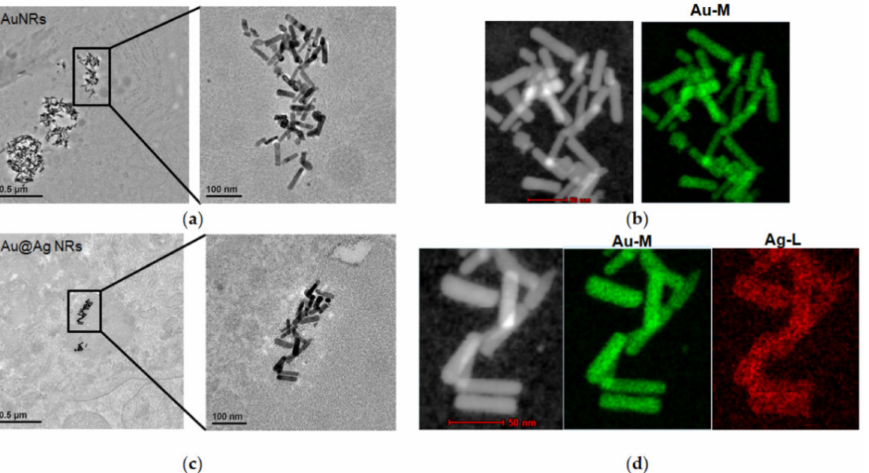
Figure 5. The existence of nanorods in hepatocytes. Representative TEM images as well as EDX mapping analysis for AuNRs ( a , b ) and Au@Ag NRs ( c , d ) in hepatocytes at 2 w after injection were